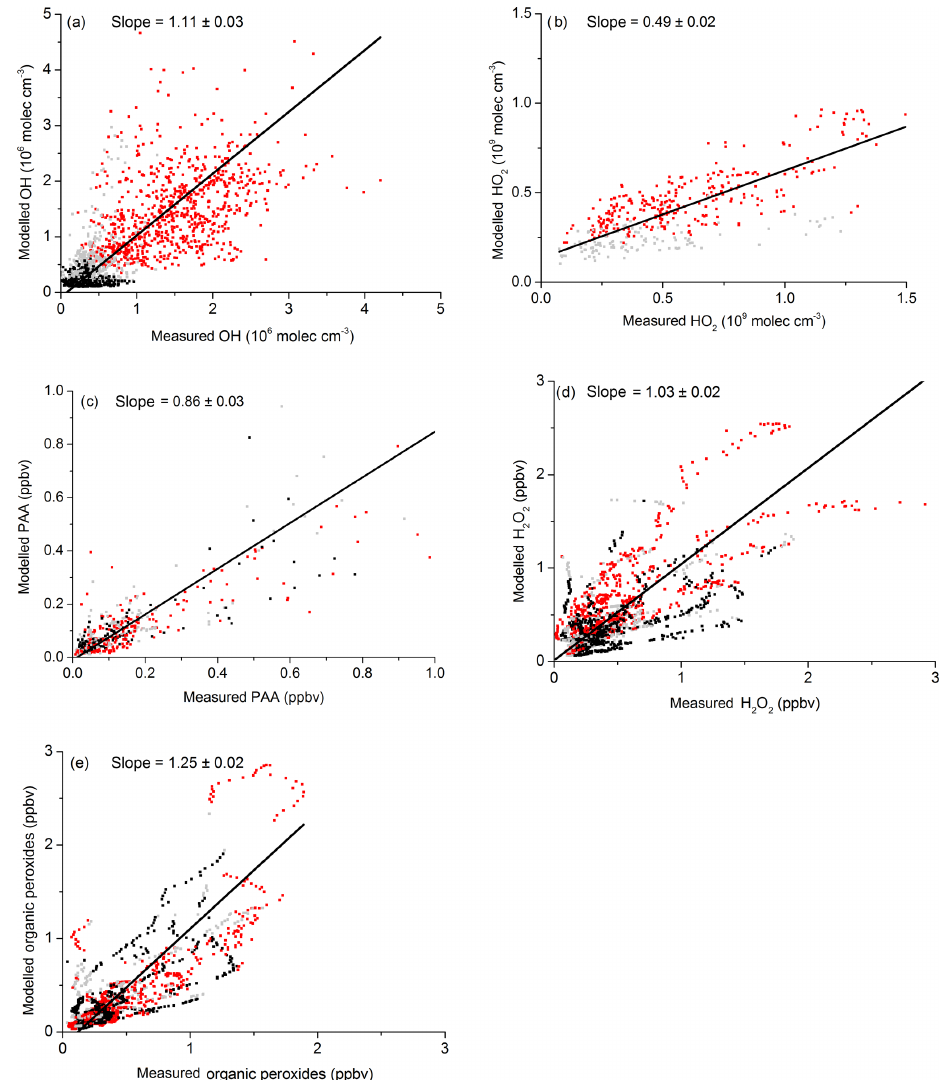
Figure 12. Measurement versus model results for OH, HO 2 , (HO ∗ and night-time. The fit lines account for uncertainty on both axes. Uncertainty is statistical (1 σ